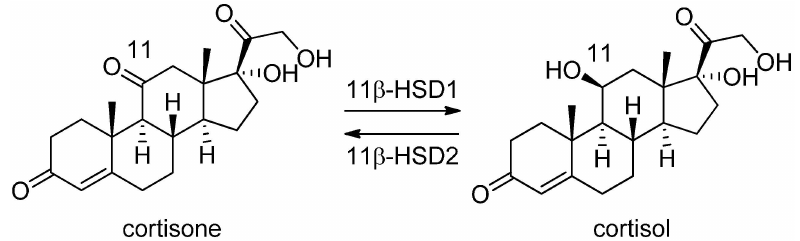
Figure 6. Interconversion of cortisone and cortisol catalyzed by the 11 β -HSD enzymes.